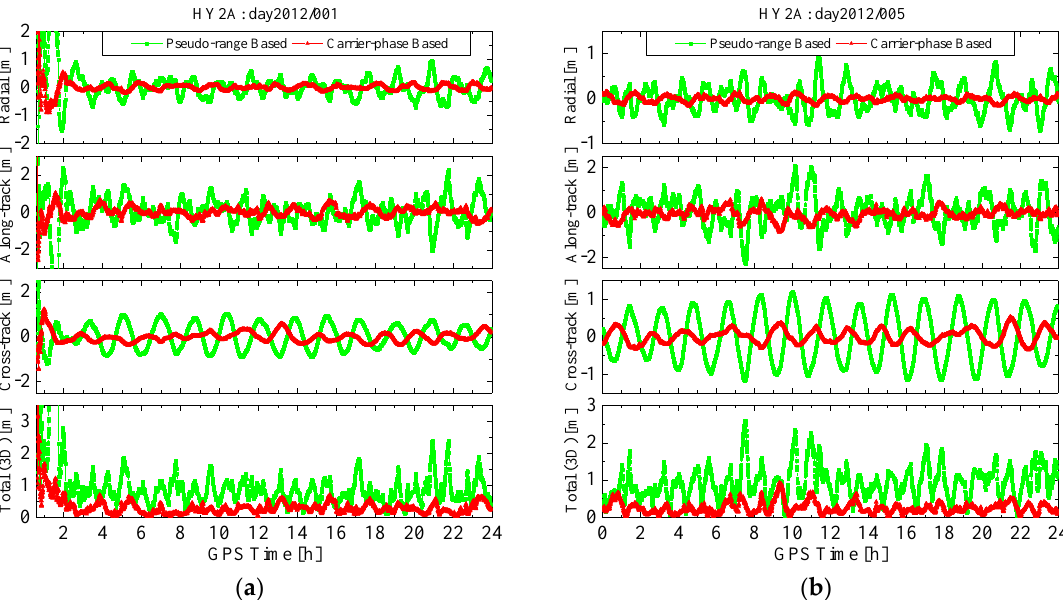
Figure 6. Position errors of real-time orbits for the HY2A satellite. ( a ) Position errors on 2012/001; and ( b ) position errors on 2012/005.